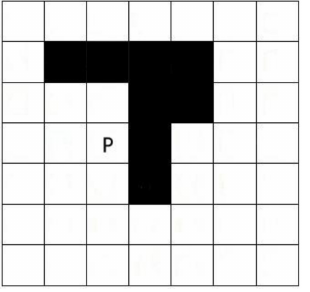
Figure 3. Development unit potential of the mixed-scale model.